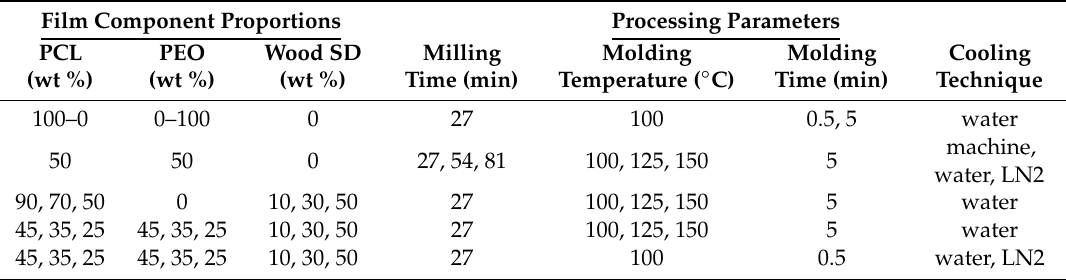
Table 2. Compression molding film experimental